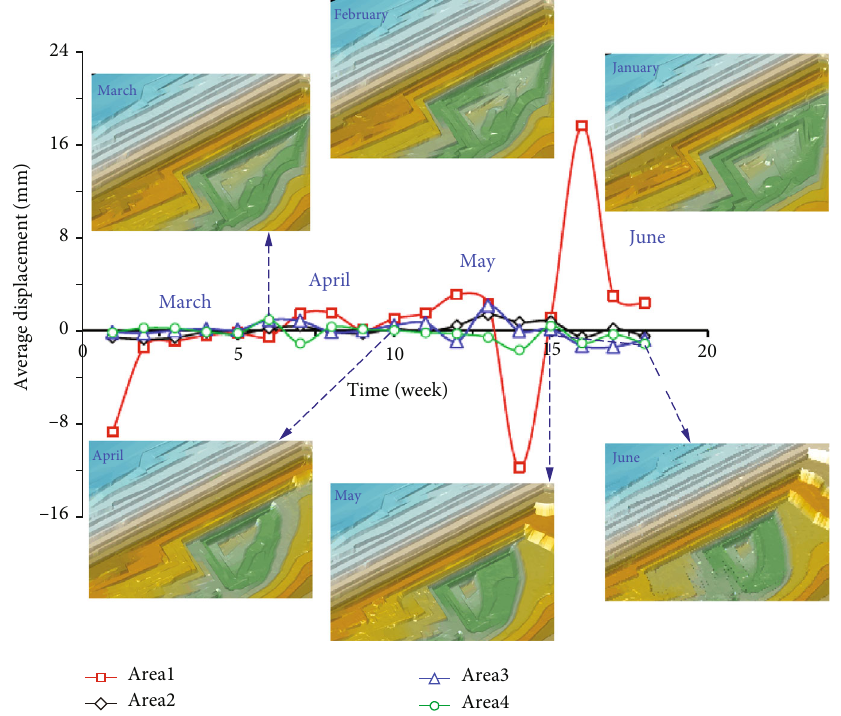
Figure 13: Deformation variation law of south slope monitored by